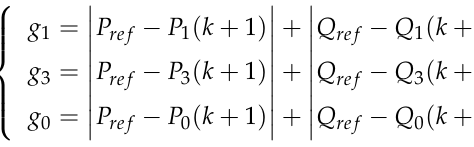
Figure 4. Duration and operation sequence diagram of voltage vector under each sector.